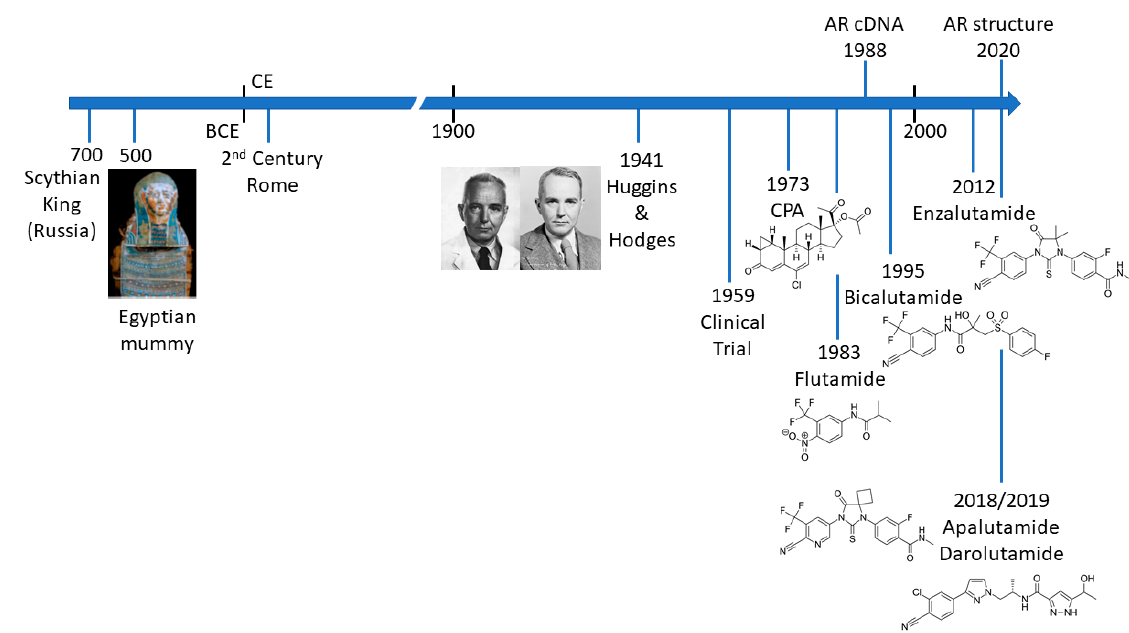
Figure 1. Timeline illustrating key events in the treatment of prostate cancer.